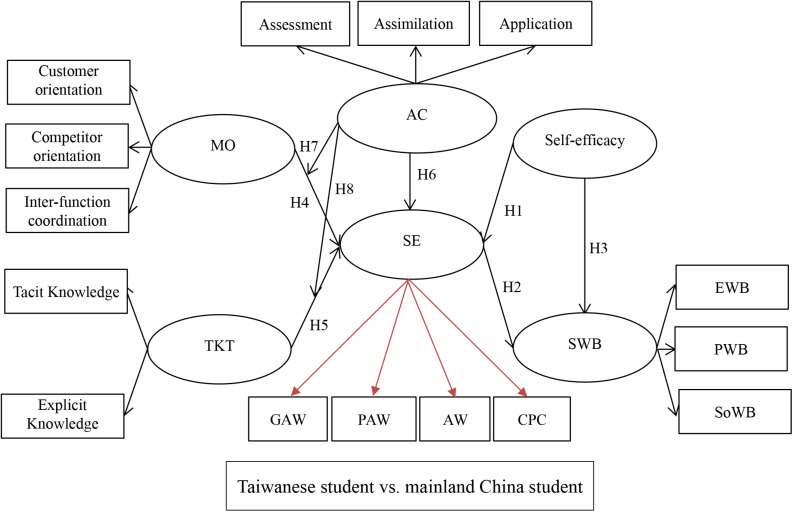
Research framework.